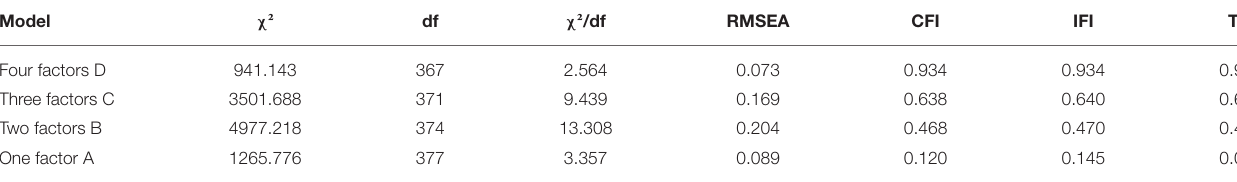
TABLE 3 | Confirmatory factor analysis. Model